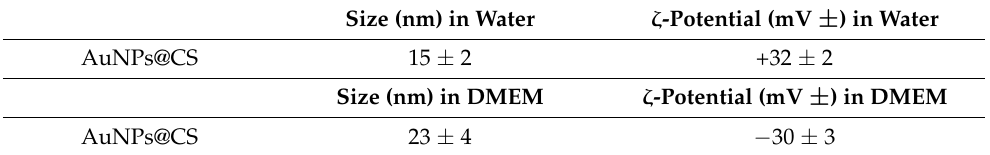
Table 1. Characterization of AuNPs@CS in water and DMEM by DLS and ζ -potential (mV) measurements. Size (nm) in